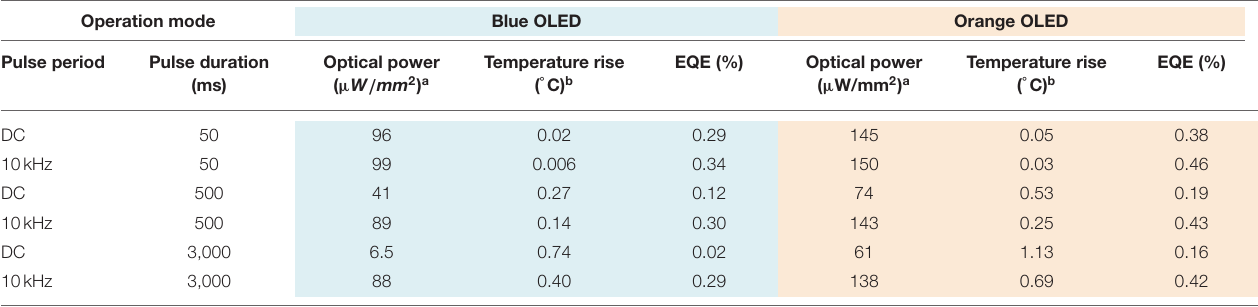
TABLE 1 | Summary of EQEs and temperature rise at different pulse durations for DC and 10kHz operation modes. Operation